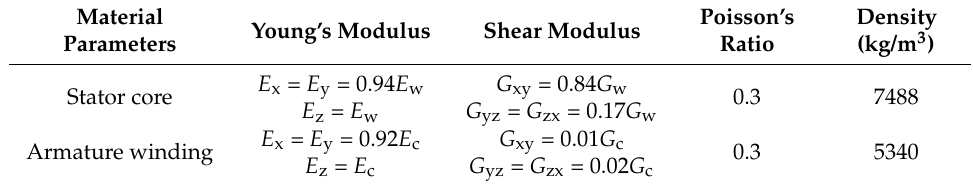
Figure 6. Stator model of HTS-FMDS machine: ( a ) Stator core; ( b ) armature windings; and ( c ) stator assemblies. Table 3. Material parameters of stator core and armature winding.